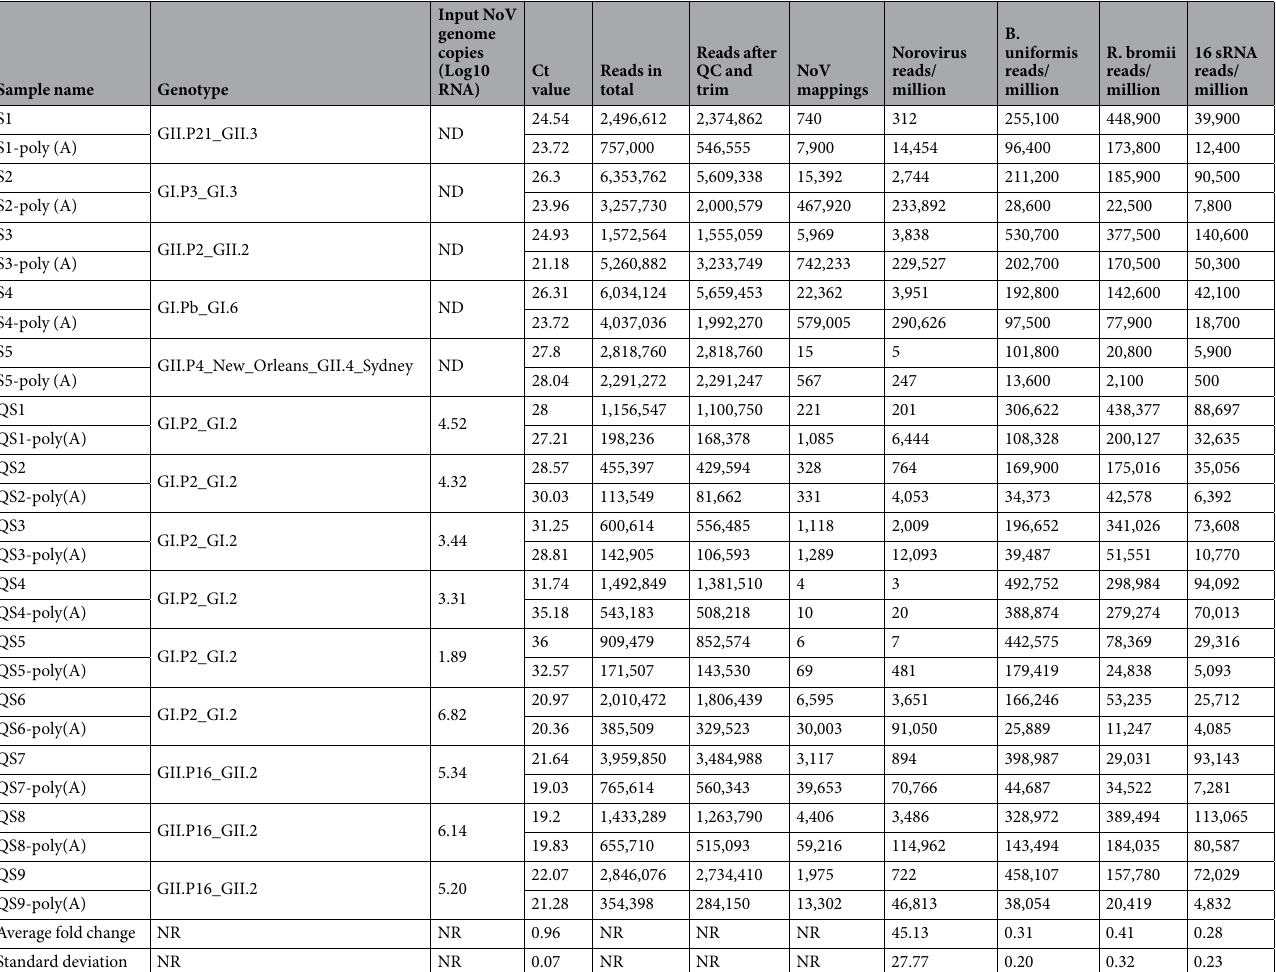
Table 1. Summary of quantification, sequencing, mapping and genotyping results of outbreak samples before and after poly(A)-capture. Legend: Column 1: Sample name (S: Survey sample, QS: Quantitative